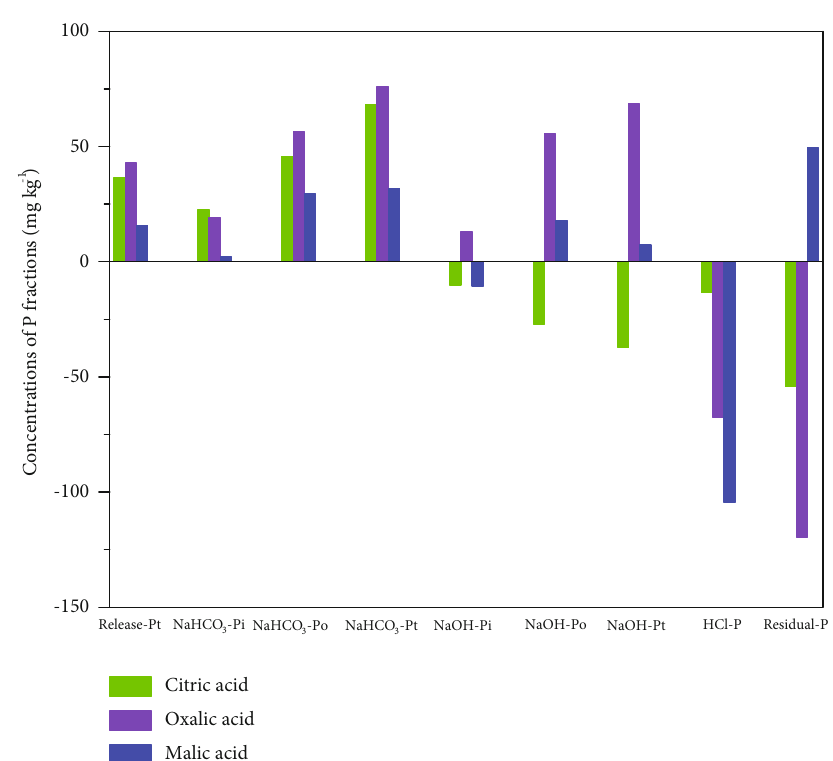
Figure 4: The variations of P fraction after addition of low molecular weight organic acids (oxalic acid, citric acid, and malic acid) compared with deionized water after 2880